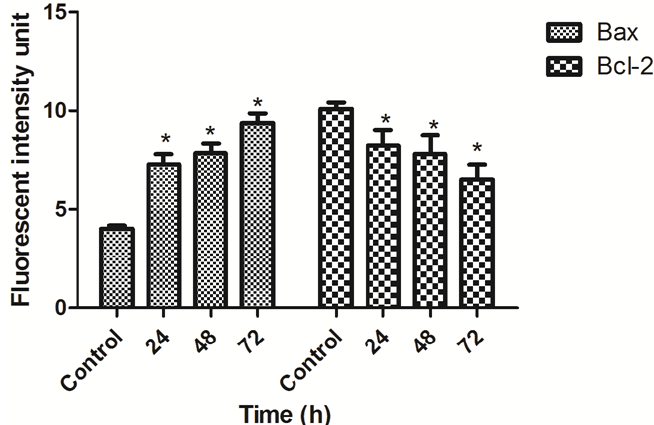
Figure 13. Quantitative analysis of Bax and Bcl-2 expression after treatment with TPHE in 24, 48 and 72 h. Histograms show the significant increase in the Bax as well as significant decrease in Bcl-2 ratio at protein level. The data are shown as the mean ± SD ( n = 3). * represents significant difference ( p < 0.05) compared with the